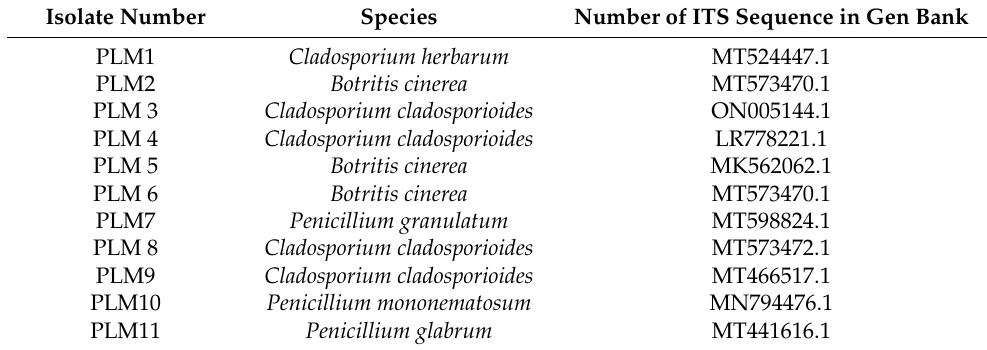
Table 4. Identification of isolated molds from the examined samples.